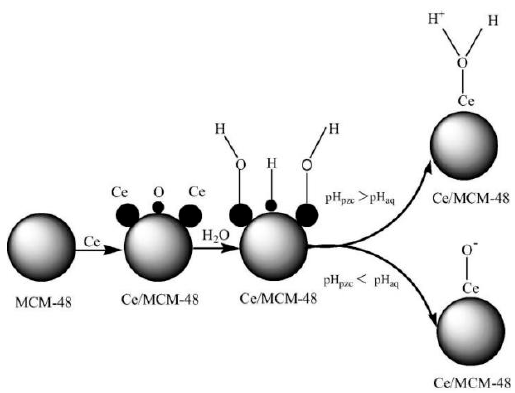
Figure 12. The probable reaction route of Ce/MCM-48 among different pH.